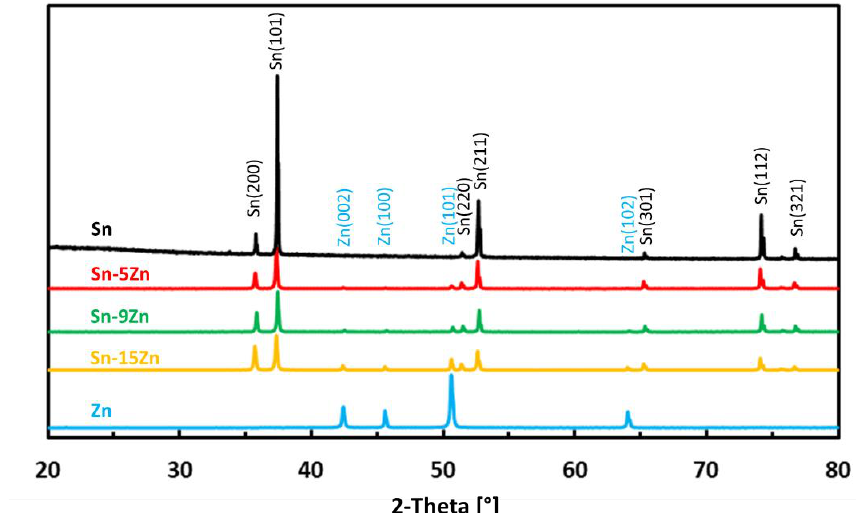
Figure 1. Room-temperature XRD patterns of as-cast Sn – Zn alloys.